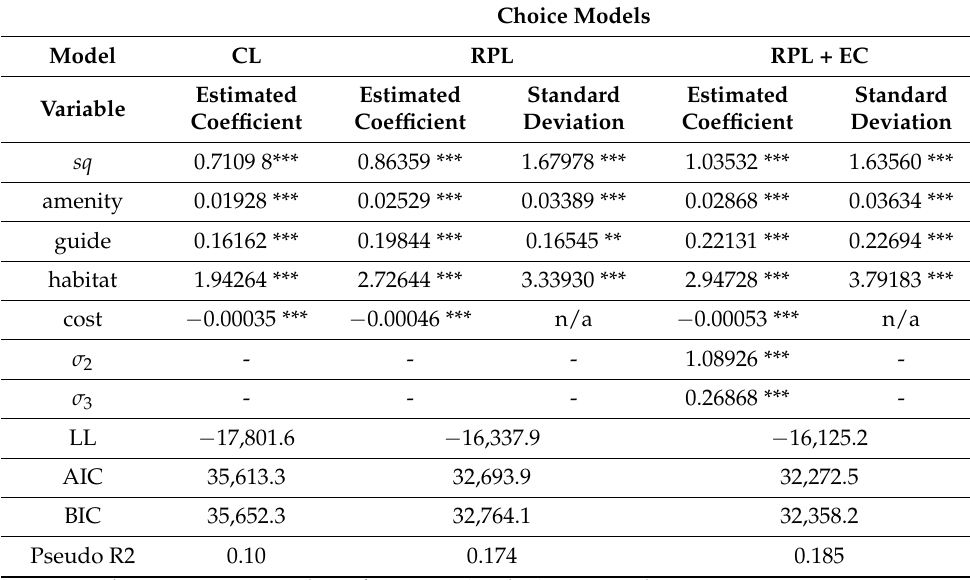
Table 4. Estimation results for CL, RPL, and RPL + EC